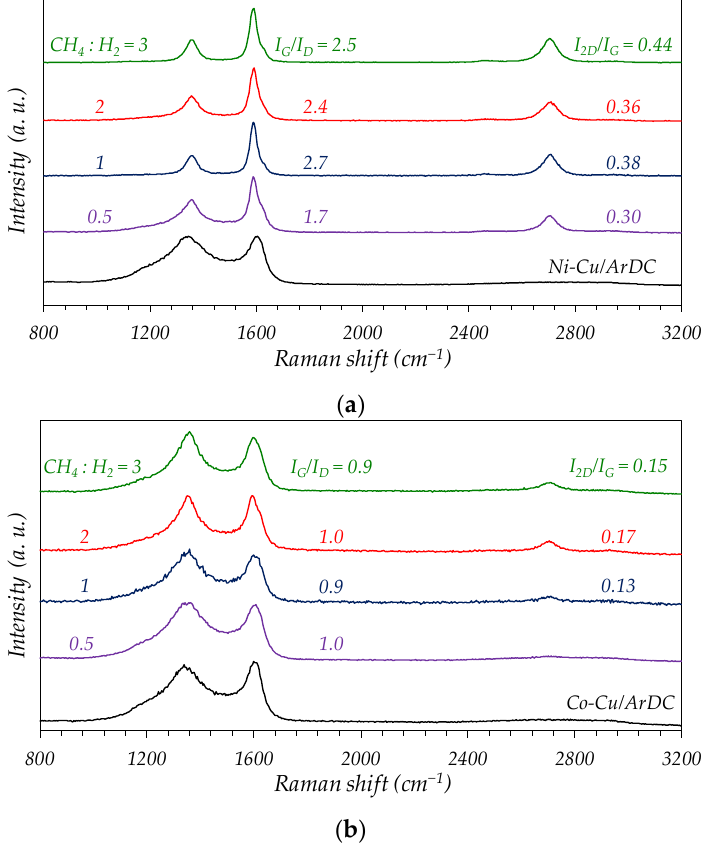
Figure 8. Raman spectra obtained for ( a ) Ni – Cu/ArDC and ( b ) Co – Cu/ArDC. Influence of feed composition (CH 4 :H 2 ratio). Reaction temperature: 800 °C.